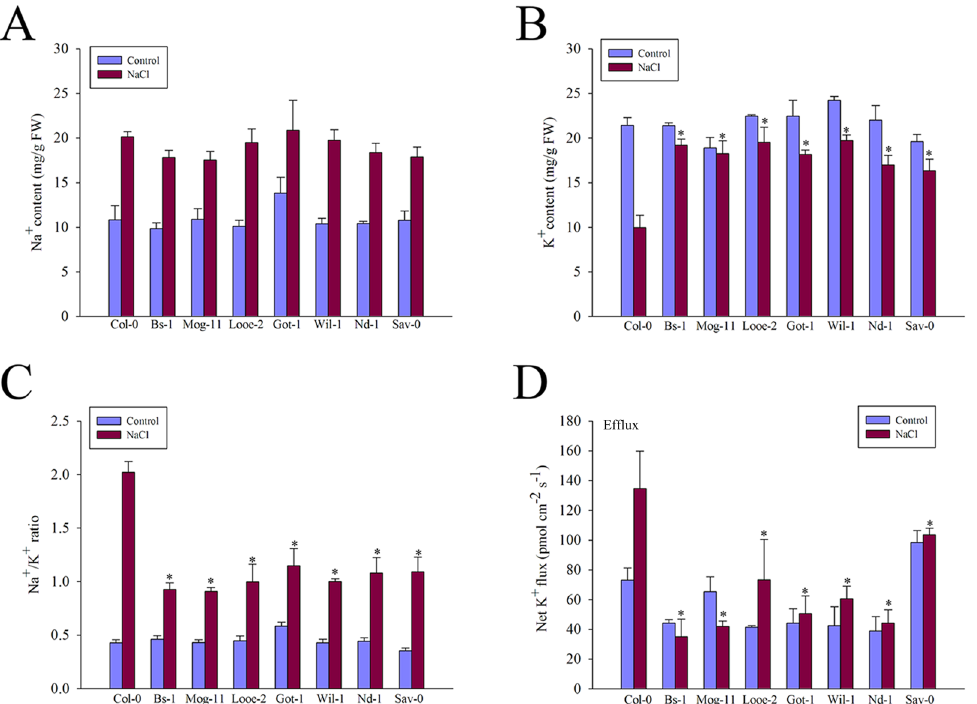
Fig 2. Changes in ion contents, Na + /K + ratio and net K + fluxes of Col-0 and the selected accessions. The whole plants treated with 0 or 200 mM for 12 h were collected and subjected to the determination. (A) Na + content, (B) K + content, (C) Na + /K + ratio and (D) Net K + fluxes in root tips. Different net K + fluxes were measured respectively in mature zones of the accessions exposed to 100 mM NaCl for 0 or 3 h, Values are mean ± SE ( n = 6 – 15 seedlings) from three independent experiments. Significant differences from the performance of Col-0 accession are indicated by * ( P < 0.05).